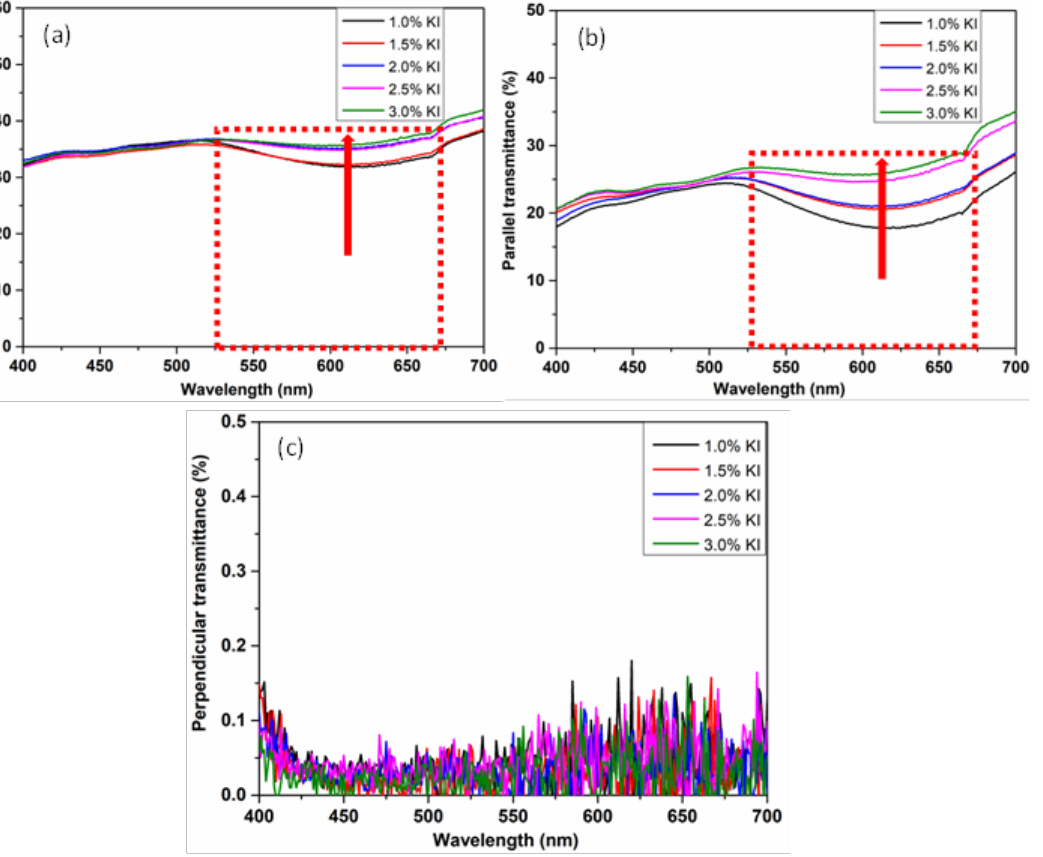
Figure 5. The ( a ) single, ( b ) parallel and ( c ) perpendicular transmittance spectrum of PVA polarizing films with the concentrations of KI being set to 1.0%, 1.5%, 2.0%, 2.5% and 3.0% respectively when the draw ratio was 6 all.